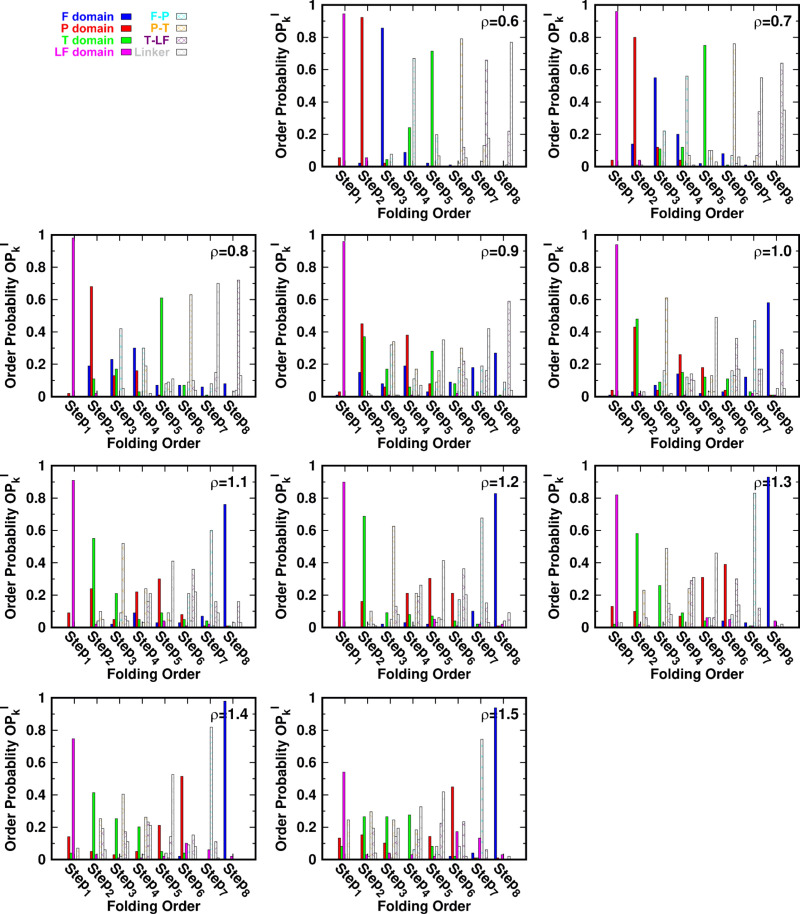
OPkI for different values of ρ at a temperature 0.96⁢Tf.Folding order probability OPkI of intra- and interdomains for different values of ρ at a temperature 0.96⁢Tf.